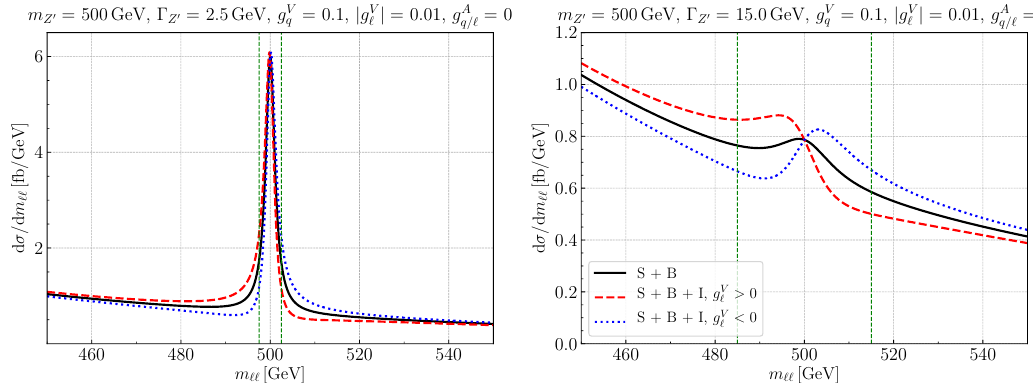
Figure 2 . Comparison of the spectrum d (cid:27)= d m ‘‘ as function of m ‘‘ for di(cid:11)erent decay widths. The left panel displays the di(cid:11)erential cross section for (cid:0) Z (cid:0) Z = 15 GeV. We show a naive addition of signal (S) and background (B) as a black line, and the 0 full result with interference (I) included as blue dotted and red dashed lines for both signs of g V In the right panel, the signal shape in the region [ m Z green lines) is clearly a(cid:11)ected by the inclusion of interference